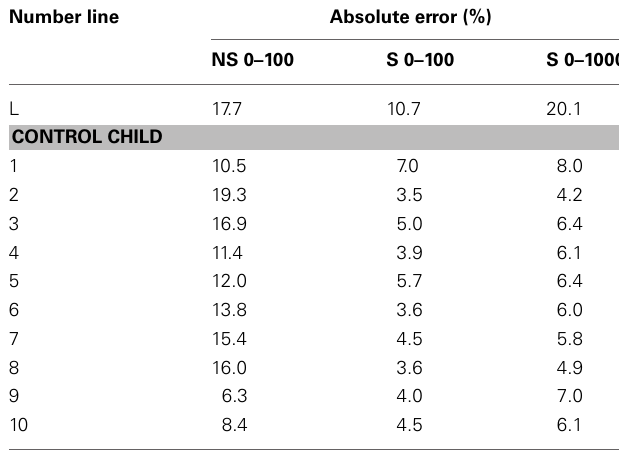
Table A1 | Overview of the individual working memory scores of the child with dyscalculia and the control children.